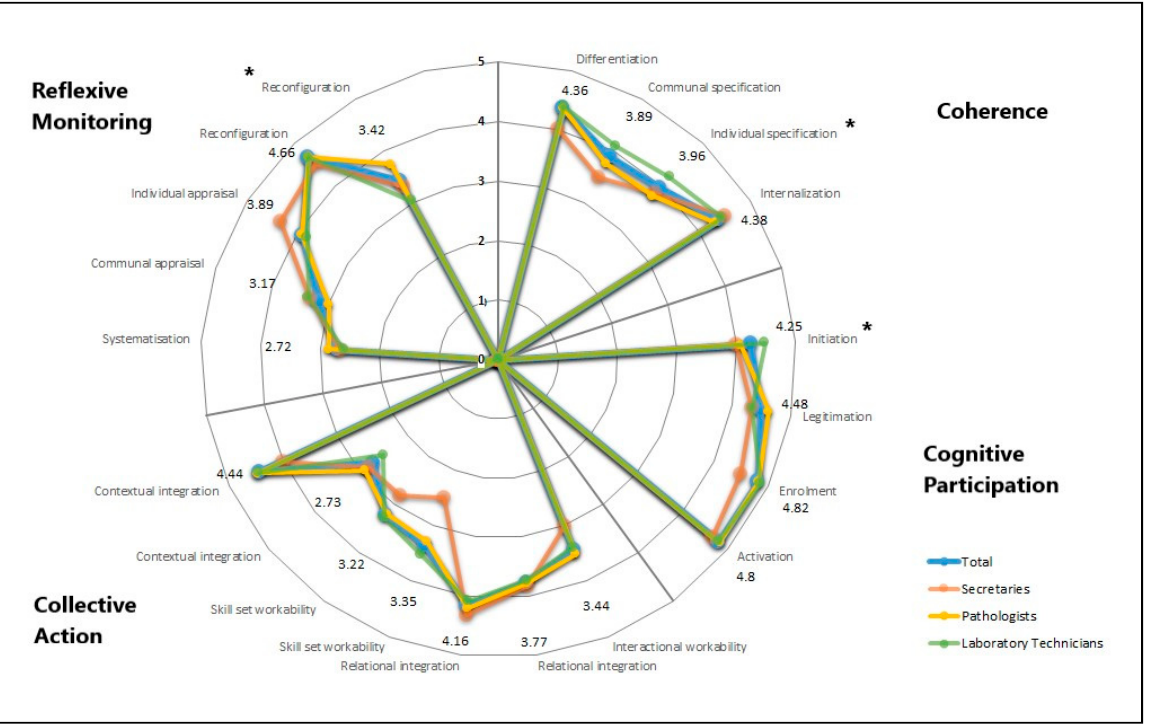
Figure 1. Petal chart showing the mean scores for each of the 16 NPT sub-constructs for the staff in total, and for each of the 3 groups of professions. Sub-constructs marked with an asterisk (*) indicate that there is significant difference in perception among the three groups of profession. The scores written are the number for the total